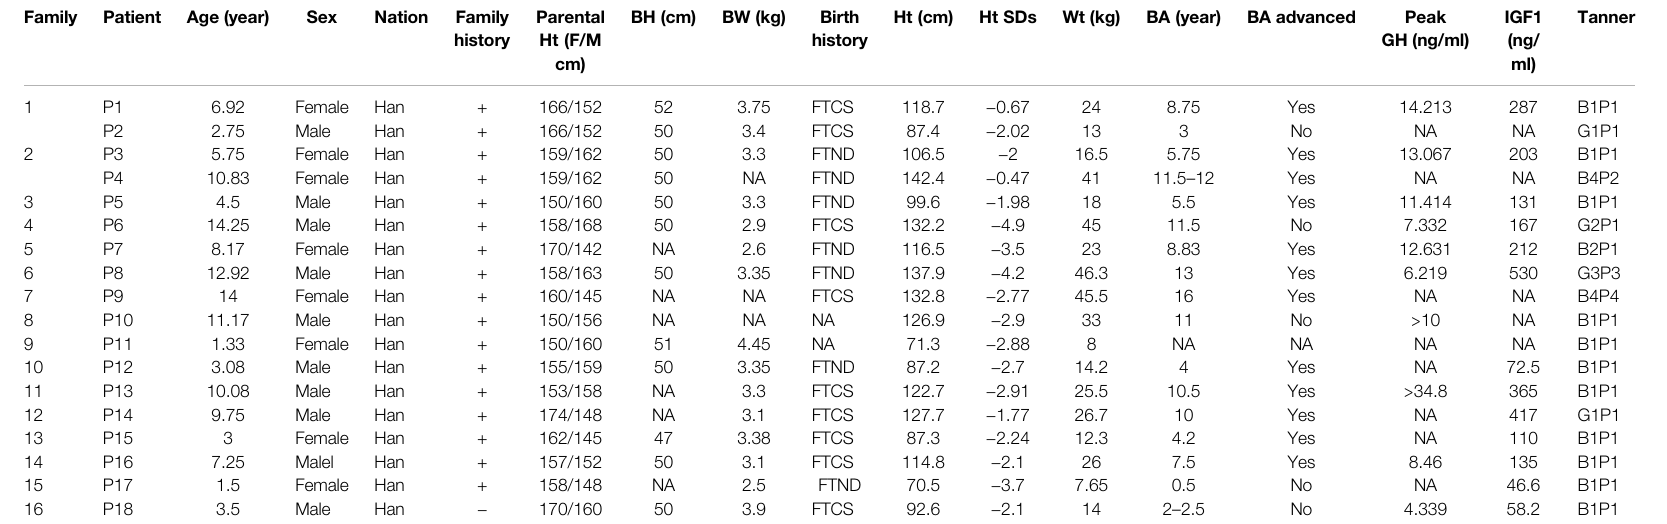
TABLE 2 | Clinical features of children with ACAN Variants.